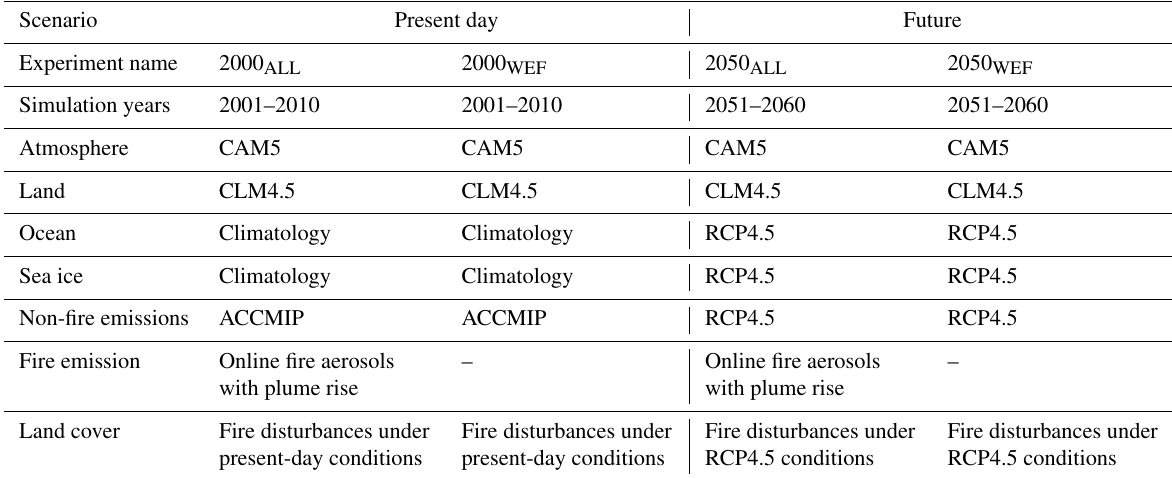
Table 1. Summary of the sensitivity simulations